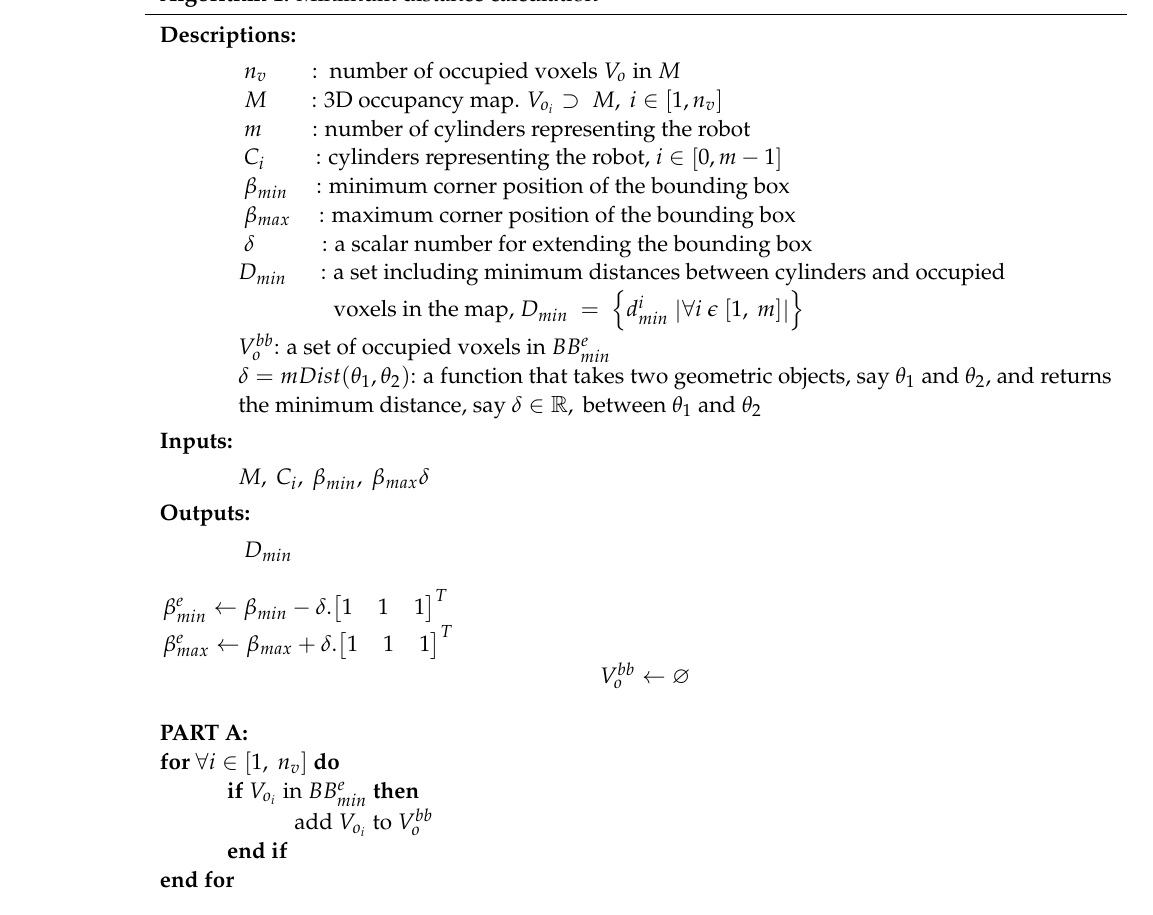
Algorithm 1. Minimum distance